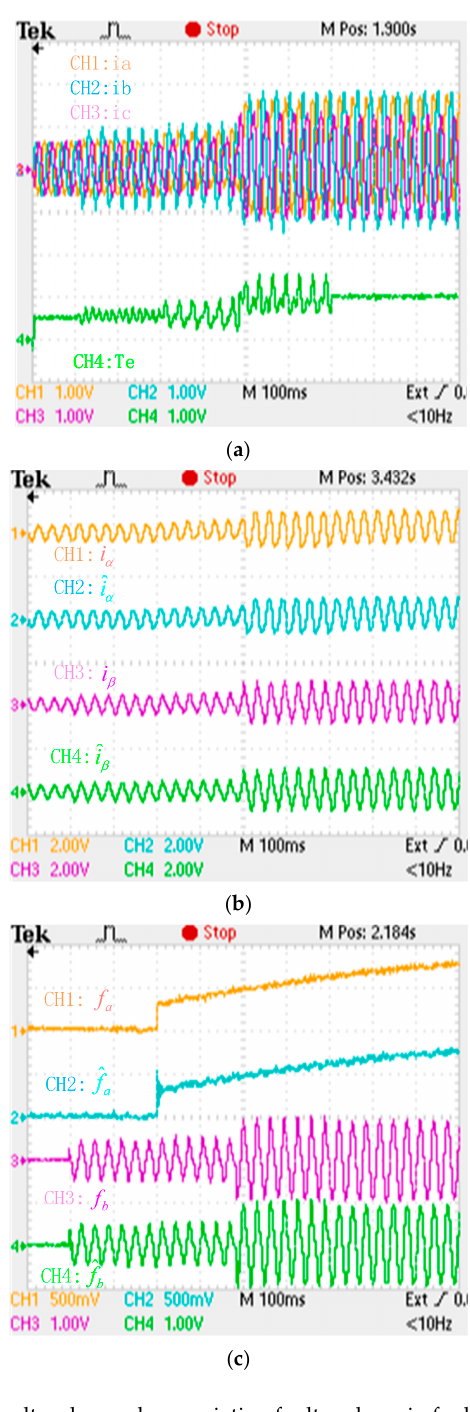
Figure 18. Experimental results when a slow-variation fault and a gain fault are respectively applied to the “a” phase current and “b” phase current sensors. ( a ) phase currents and electromagnetic torque (iabc: 150 A/div; Te: 1000 Nm/div; t: 100 ms/div); ( b ) actual and estimation αβ axis stator currents (i α : 500 A/div; i β : 600 A/div; t: 100 ms/div); ( c ) phase currents fault and its reconstruction (fa: 50 A/div; fb: 100 A/div; t: 100 ms/div). can effectively reconstruct intermittent offset faults, slowly varying offset faults and abrupt gain faults of the current sensor, and the αβ axis current fault processing module can restrain the torque